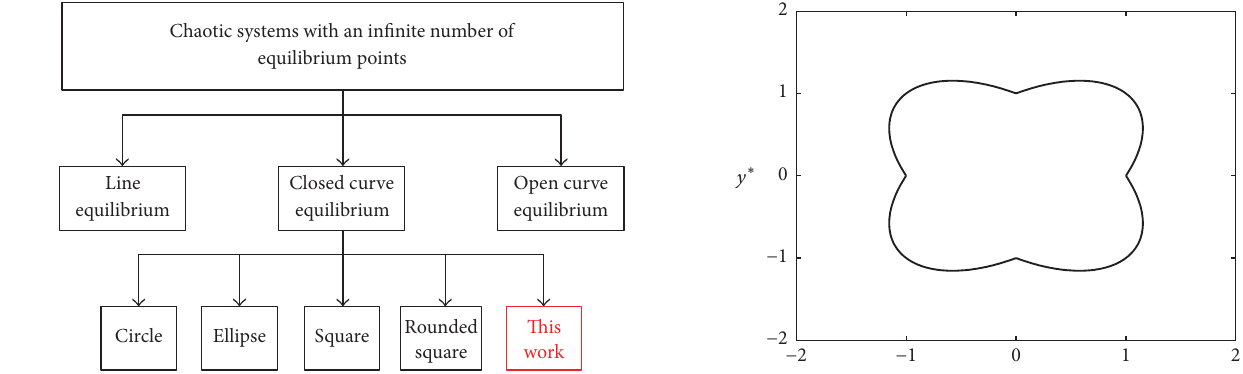
Figure 2: The special shape of equilibrium points in the new system